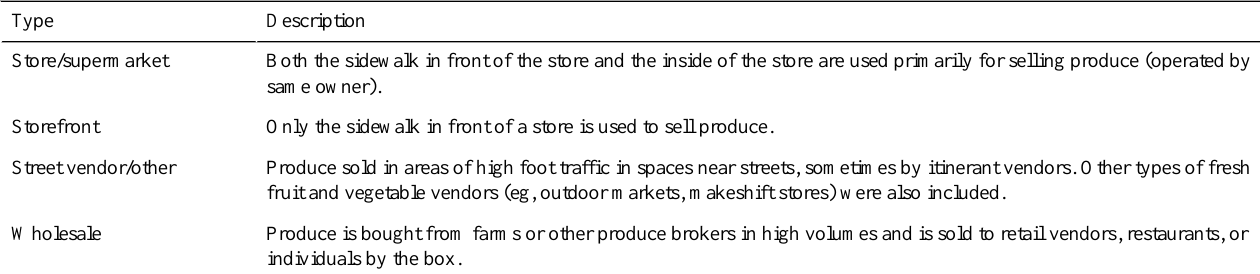
Table 2. Types of fresh fruit and vegetable vendors analyzed, adapted from a study by Imbruce